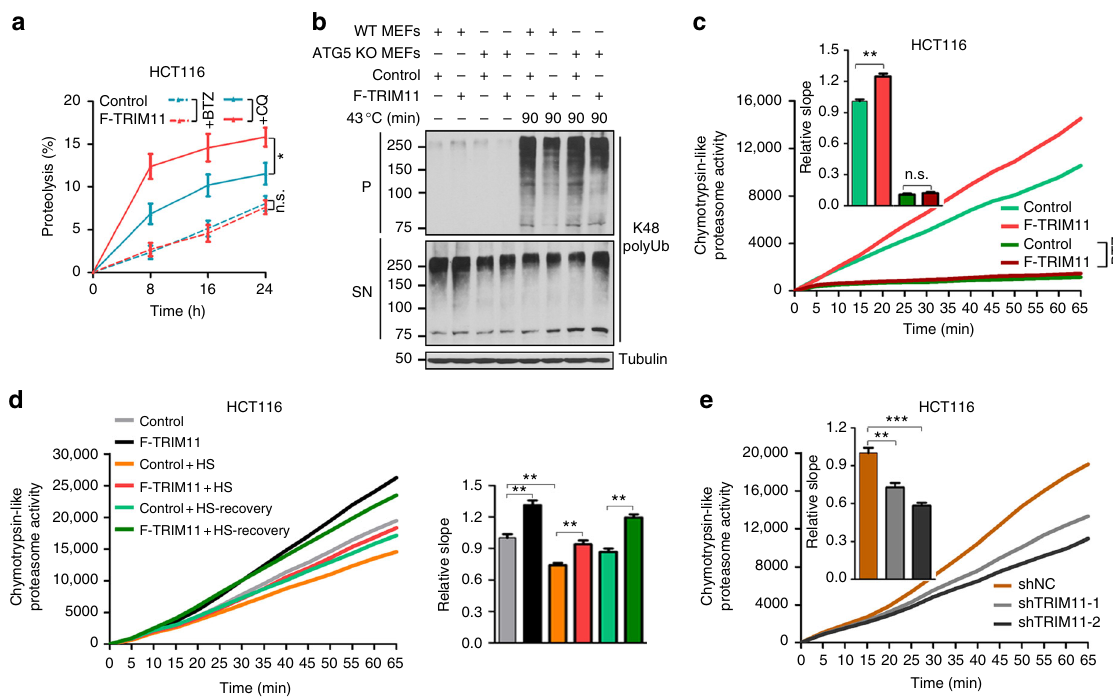
Fig. 3 TRIM11 activates the proteasome. a Overall proteolysis in control and TRIM11-overexpressing HCT116 cells treated with BTZ (0.5 μ M) or CQ (50 μ M). b Levels of K48 polyUb conjugates in wild-type and Atg5 KO MEF infected with vector or TRIM11 lentiviruses, and grown under normal or heat stress conditions. c , d Chymotrypsin-like proteasome activity in TRIM11-overexpressing HCT116 ( c ), TRIM11-depleted HCT116 cells ( d ), and the corresponding control cells, as measured by fl uorometric substrate Suc-LLVY-AMC. In c , cells were also treated with BTZ (200 nM, 4 h). Slopes relative to that of control are shown, n = 7 ( c , without BTZ), 6 ( c , with BTZ), and 8 ( d ). e Chymotrypsin-like proteasome activity in control and TRIM11-overexpressing HCT116 cells cultured under unstressed, heat shock, and heat shock/recovery conditions. Slopes relative to that of control are shown, n = 7. In a and c – e , data represent the mean ± SEM ( n = 3, unless otherwise indicated). * P < 0.05; ** P < 0.01; *** P < 0.001. Uncropped blots are presented in Supplementary Fig. 10. n.s.: